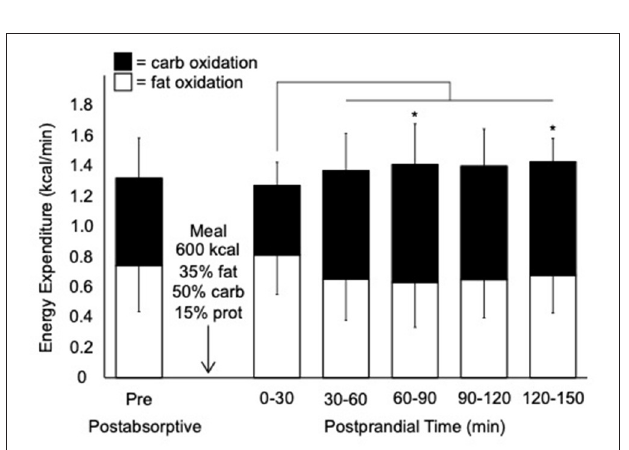
FIGURE 2 | Rates of total, carbohydrate, and fat expenditure before and after consumption of a liquid mixed meal. Values are mean ± SD; n = 10. kcal; kilocalorie; carb, carbohydrate; prot, protein. Thin line denotes a significant increase in carbohydrate oxidation compared to 0–30min postprandial ( p < 0.05). *Significant difference in carbohydrate oxidation compared to postabsorptive pre ( p < 0.05).